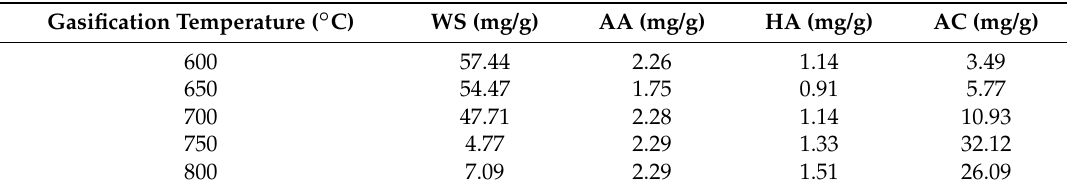
Figure 5. Variation of occurrence mode of K with gasification temperature. Table 7. Occurrence modes and contents of K.